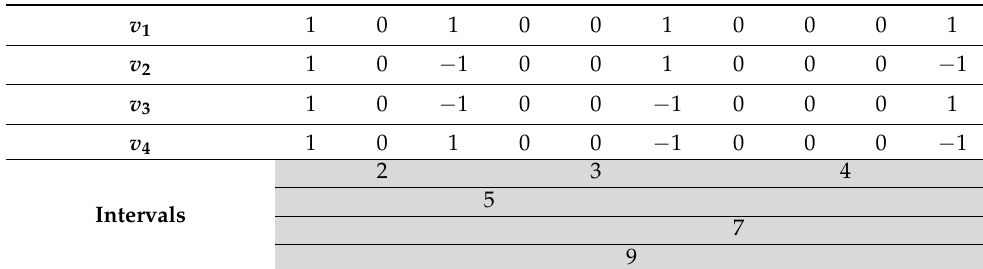
Table 1. Table of the four non-zero-bit HAPI codes derived from the rows of the 4 × 4 Hadamard matrix.